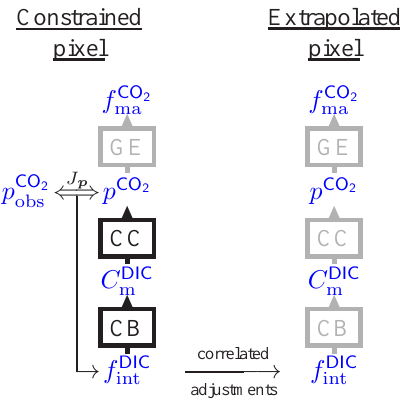
Fig. 5. Illustration of the information flow in the spatio-temporal extrapolation through a-priori correlations. Where data values ex- ist, pixels are directly constrained (left column, which is identical to Fig. 2). Due to the a-priori spatial correlations (Appendix A2.2), adjustments to f DIC at the constrained pixel also change f DIC at int int neighbouring unconstrained pixels. p CO 2 is then calculated pas- sively from the extrapolated f DIC by the process parameterizations, int using the local values of the driving fields (right column). In data-dense areas, local adjustments to f DIC (both for constrained int and for extrapolated pixels) will need to compromise between sev- eral data constraints within the correlation radius (de-weighted with distance due to the decay of the correlation, Fig. A1). As with any smoothing, this may be beneficial in suppressing outliers, but also adverse in partly suppressing small-scale signals (the structures from the driving data of the parameterizations are never smoothed however, as the smoothing only acts on f DIC ). In data-poor areas, int there may exist pixels that do not have any constrained pixel within the correlation radius; then f DIC will stay close to the prior. int In time, extrapolation happens not only due to the a-priori correla- tions, but additionally due to the memory effect resulting from the relaxation time of the budget equation Eq. (A21).